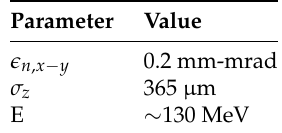
Table 2. Main beam parameters at the injector